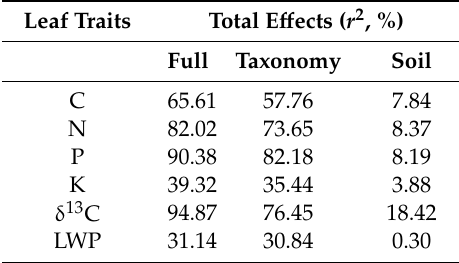
Table 6. General linear model (GLM) summary for the effects of taxonomy and soil factors on the concentrations of leaf traits.